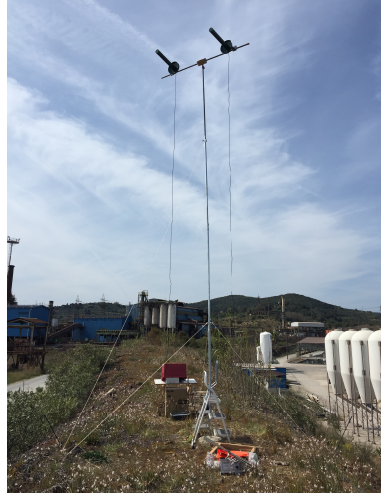
Figure 6. Ashore setup of the